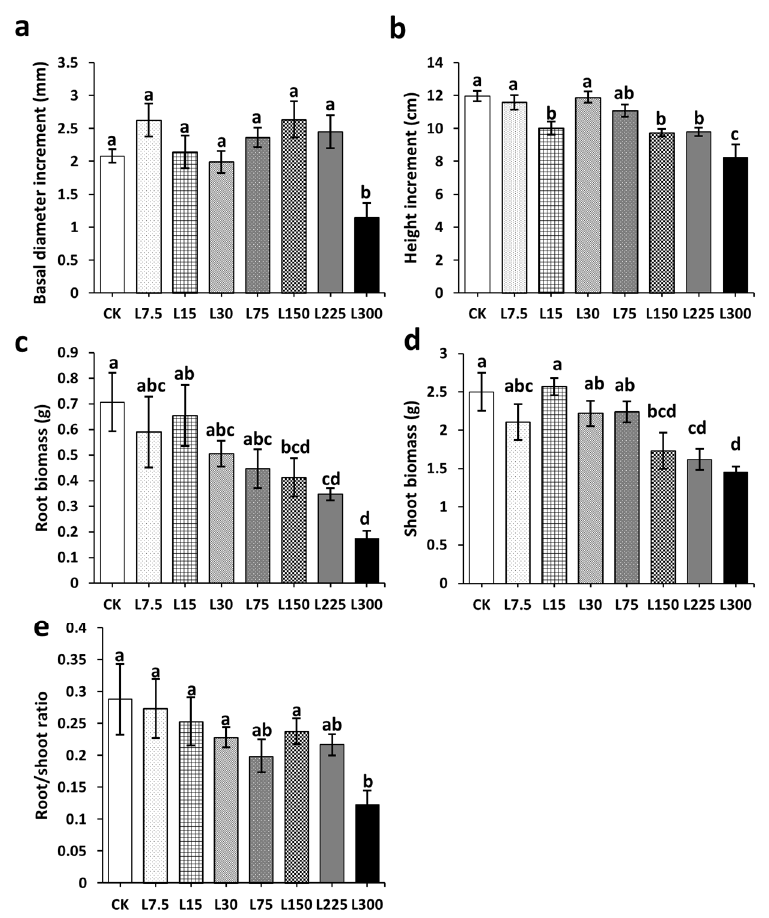
Figure 2. Effect of Cd stress on morphological traits of Tagetes patula . ( a ) Basal diameter increase and ( b ) height increase were measured by subtracting the basal diameter and height from day 0 to day